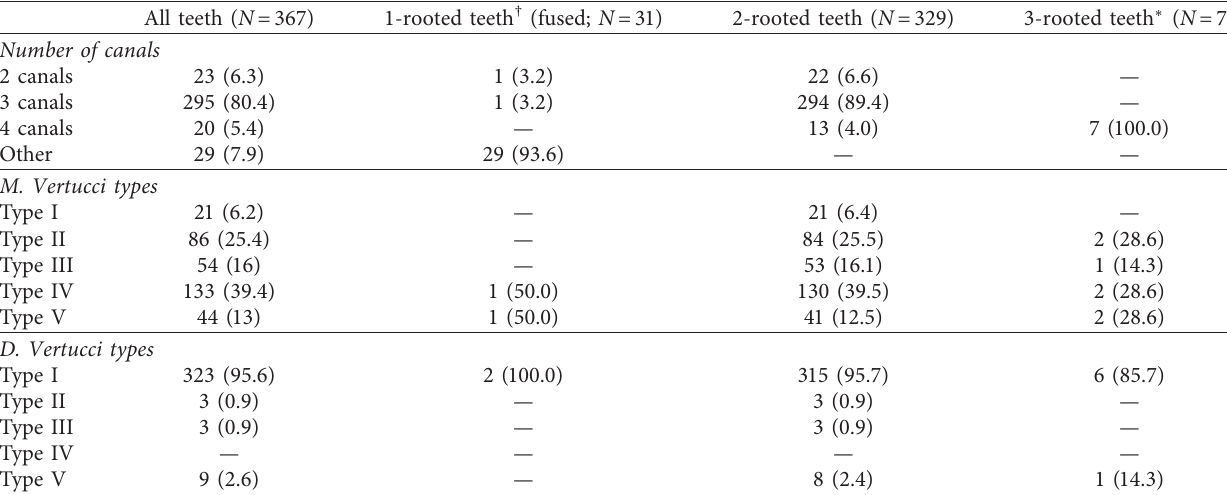
Table 3: Frequency of number of roots, number of canals, and Vertucci type among mandibular 2 nd molars N (%). All teeth ( N �